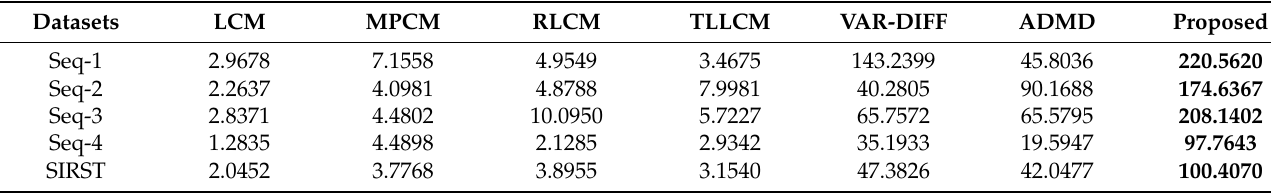
Table 2. SCRG of different algorithms.